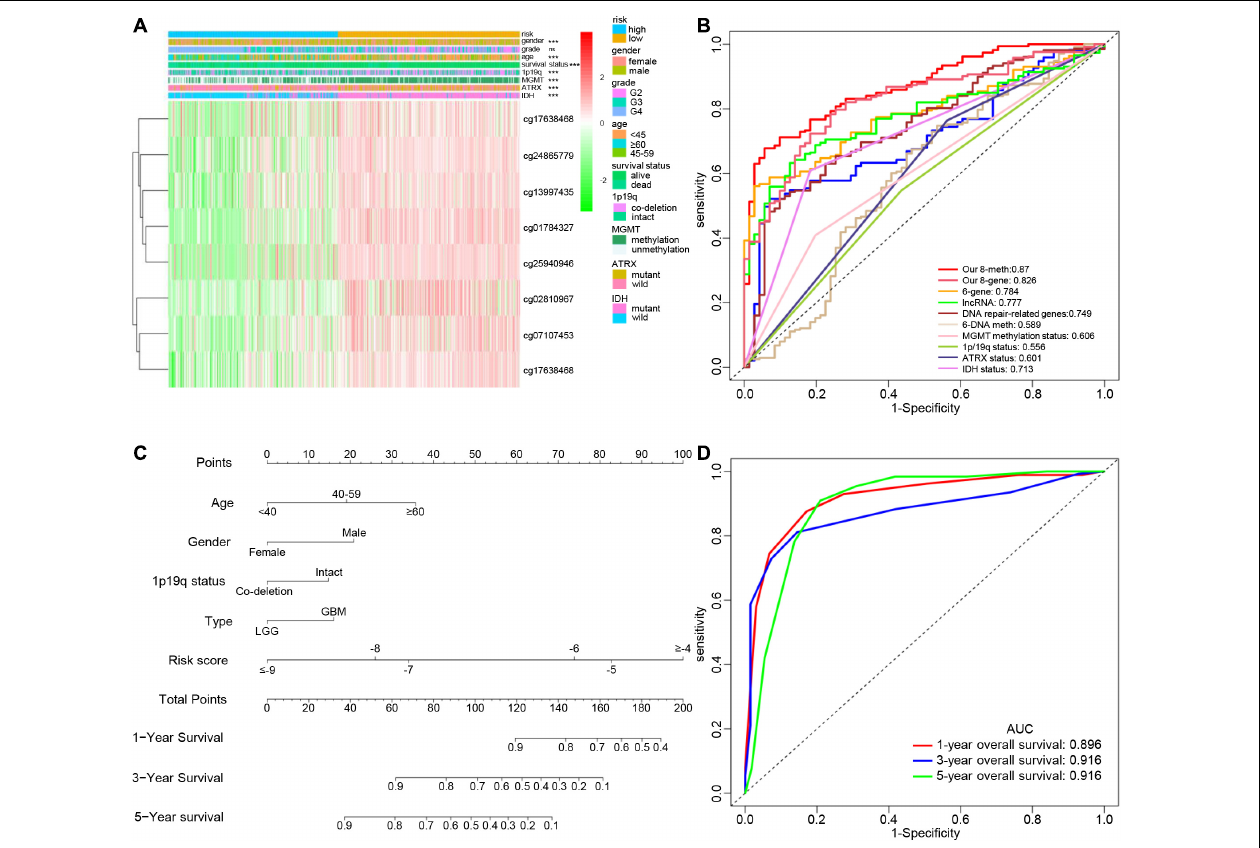
FIGURE 5 | Clinical significance of the epigenetic signature. (A) Heatmap view of the methylation degree of eight DNA methylation sites with genomic and clinical characteristics and Chi-square test results. (ns, P > 0.05, *** P < 0.001). (B) ROC curves showing the sensitivity and specificity of the epigenetic signature and other known biomarkers in predicting the overall survival of glioma patients. (C) Development of a nomogram for predicting probabilities of patients with 1-, 3-, and 5-year overall survival. (D) ROC curve based on the nomogram for 1-, 3-, and 5-year overall survival probability. Abbreviations: K-M, Kaplan-Meier; ROC, receiver operating characteristic; AUC, area under the